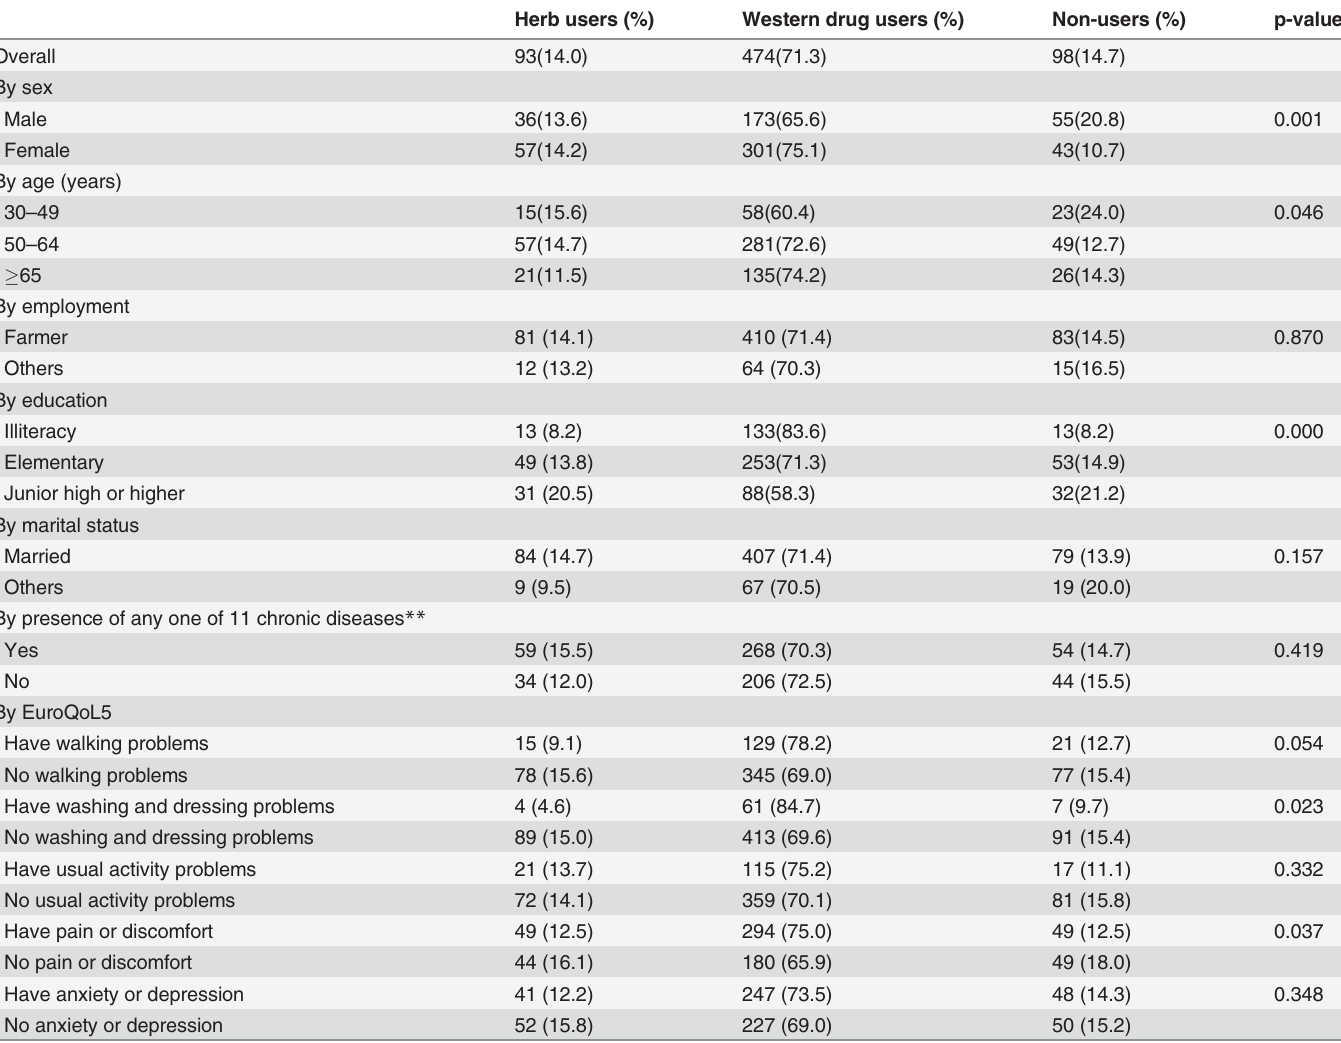
Table 2. Rate of Chinese herbal therapy and western drug use * (%) among patients with diagnosed hypertension. Herb users